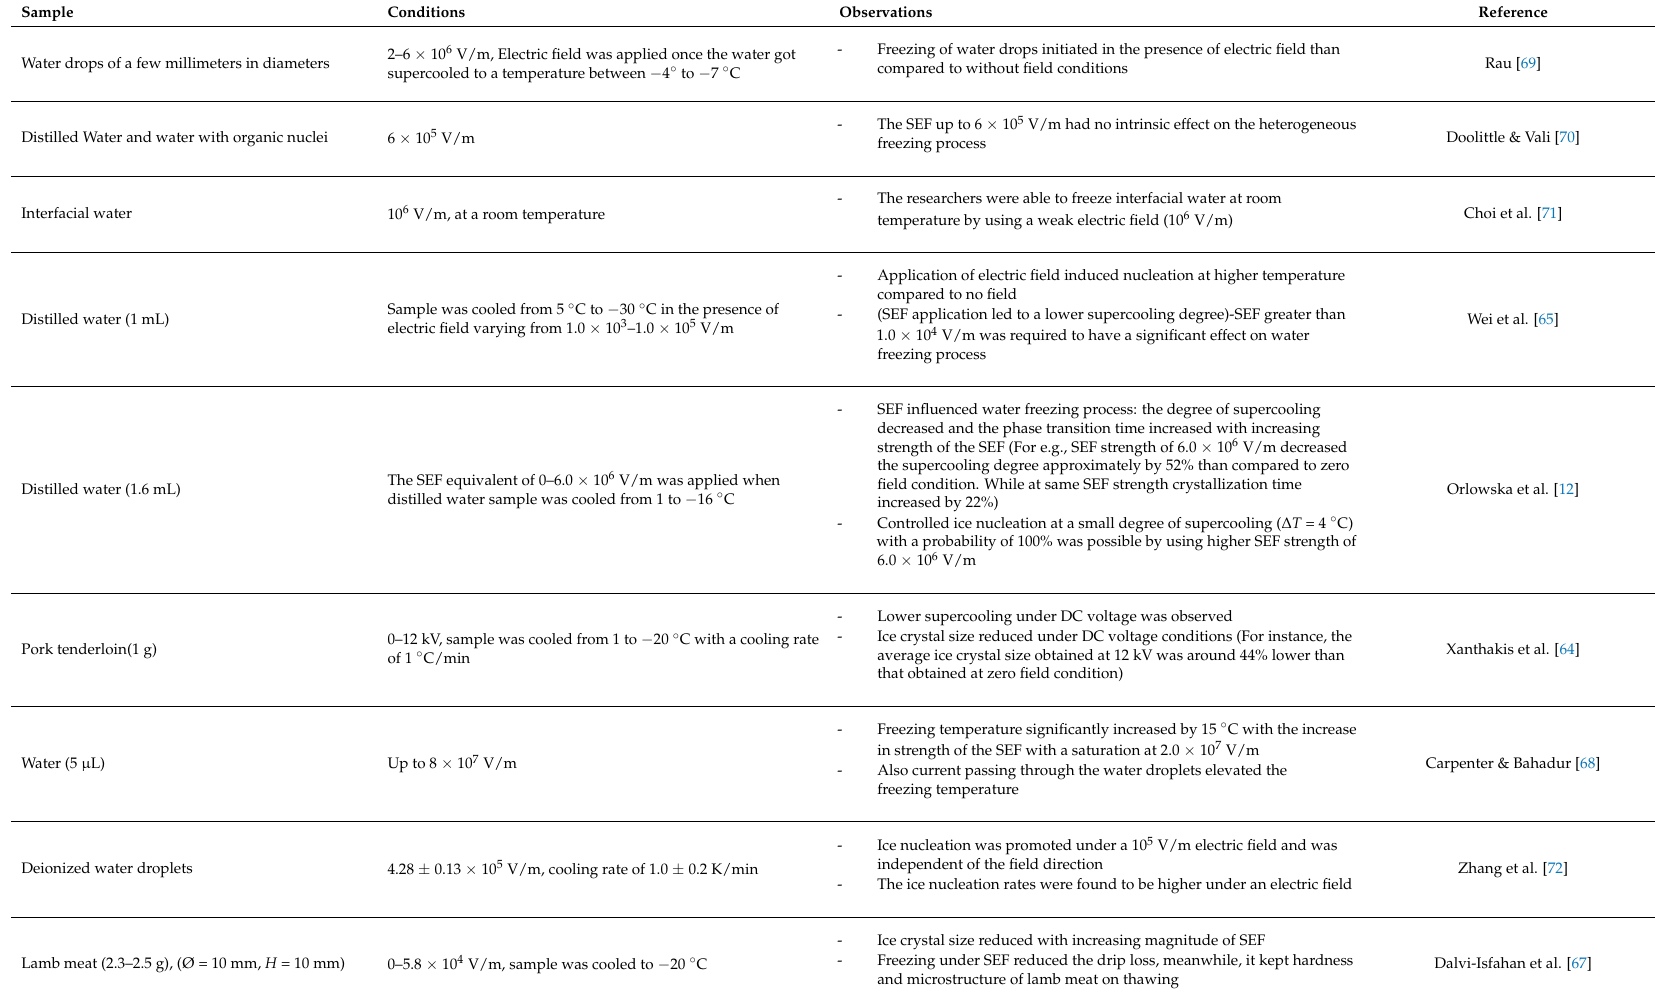
Table 1. Key published studies on the use of SEF assisted freezing for model and real food